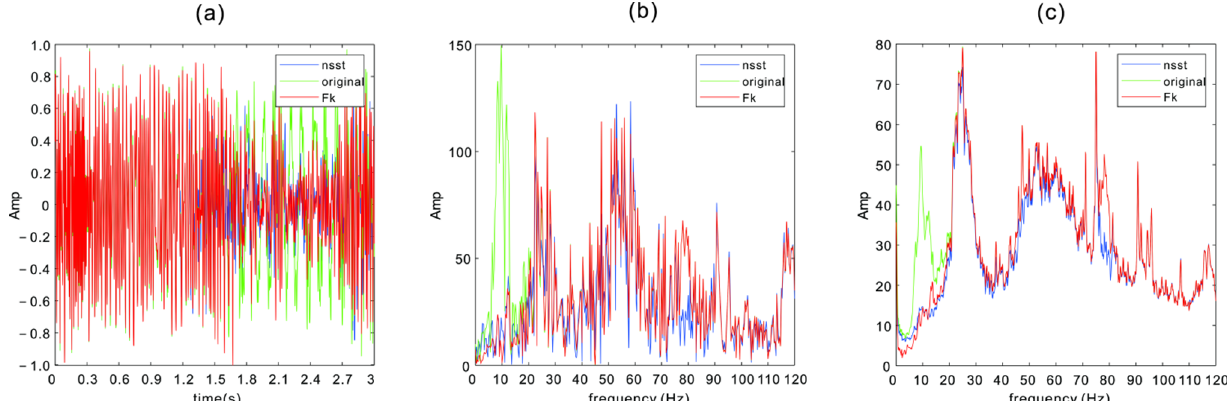
Figure 9. Waveform and amplitude spectra of the seismic data. ( a ) The waveform of trace 80 of the original seismic data (the green curve), the denoised seismic data by the NSST (the blue curve), and the denoised seismic data by the FK filter (the red curve). ( b ) The amplitude spectra of trace 80 of the original seismic data (the green curve), the denoised seismic data by the NSST (the blue curve) and the denoised seismic data by the FK filter (the red curve). ( c ) The average amplitude spectra of the original seismic data (the green curve), the denoised seismic data by the NSST (the blue curve) and the denoised seismic data by the FK filter (the red curve).